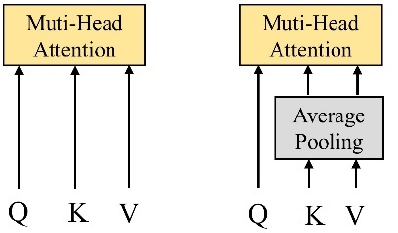
Figure 8. The comparison of original MHA and linear MHA.